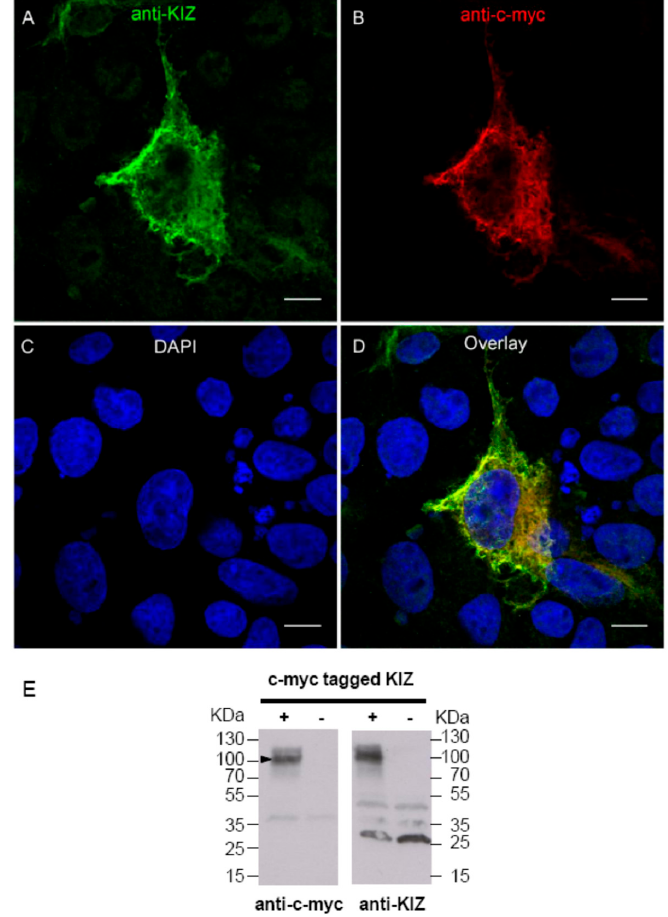
Figure 4. An anti ‐ KIZ antibody is able to detect human KIZ in mammalian cells overexpressing c ‐ myc ‐ tagged KIZ. ( A ) The anti ‐ KIZ antibody revealed intracellular staining (green) of c ‐ myc ‐ tagged human KIZ. ( B ) The anti ‐ c ‐ myc antibody revealed intracellular staining (red) of c ‐ myc ‐ tagged human KIZ. ( C ) Nuclei were stained with DAPI. ( D ) Merged staining reveals a costaining (yellow) indicating that both anti ‐ KIZ and anti ‐ c ‐ myc antibodies detected the human KIZ in overexpressing COS ‐ 1 cells. Scale bar represents 10 μ m. ( E ) The anti ‐ c ‐ myc and anti ‐ KIZ antibodies detected a band at ~100 KDa (filled arrow head in protein extract of mammalian cells overexpressing c ‐ myc ‐ tagged KIZ (left and right blot). The band at ~100 KDa was absent in untransfected cells when stained with anti ‐ c ‐ myc (left blot) and anti ‐ KIZ (right blot).